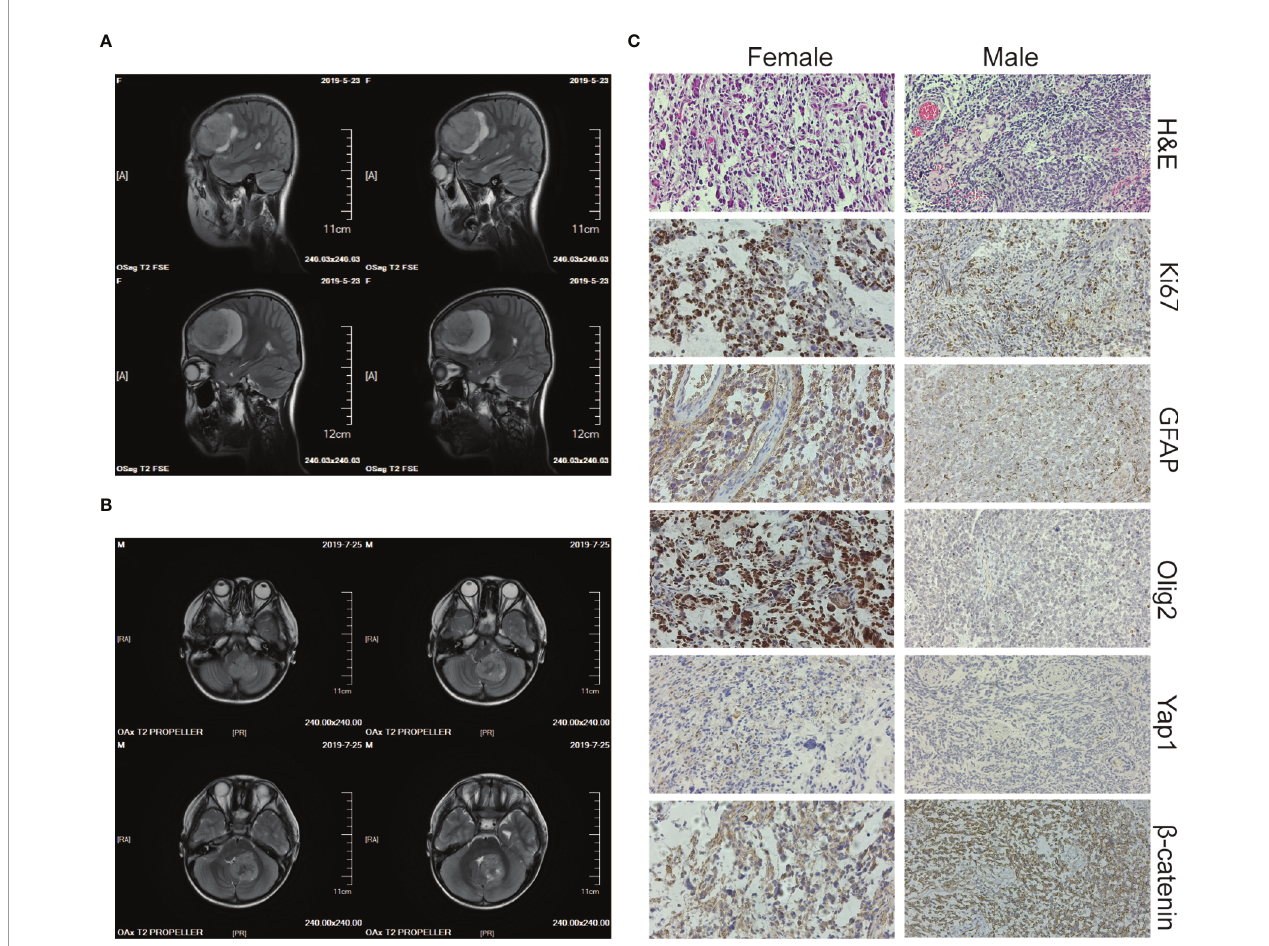
FIGURE 1 | Imaging and histology of the brain tumors. (A, B) CT scan images of the brain tumor tissue of the female (upper panels) and the male (lower panels). (C) H&E, Ki67, GFAP, Olig2, Yap1, and b -catenin staining of the female ’ s (left panels) and the male ’ s (right panels) brain tumor tissue. The magni fi cation is